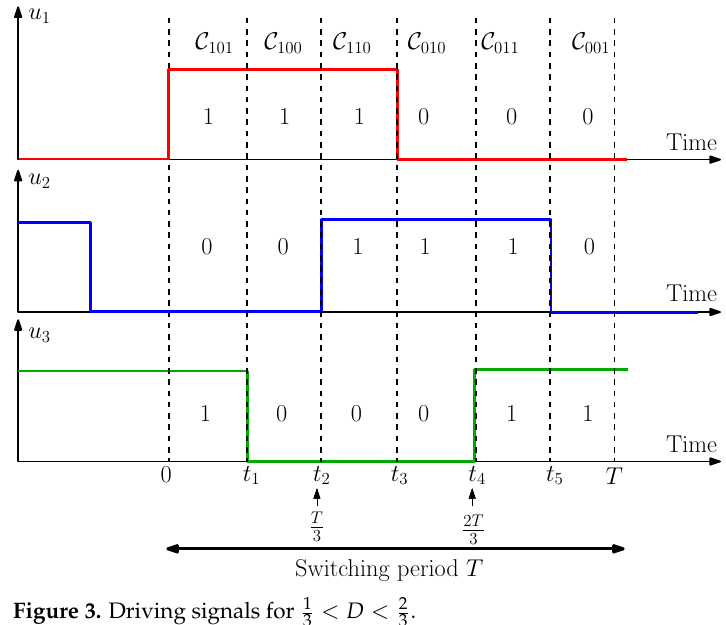
Figure 3. Driving signals for 1